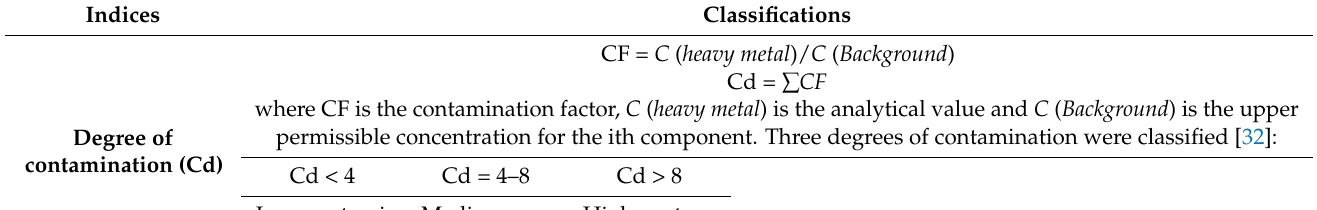
Table 1. Indices used in the analysis of HM contamination levels and water quality